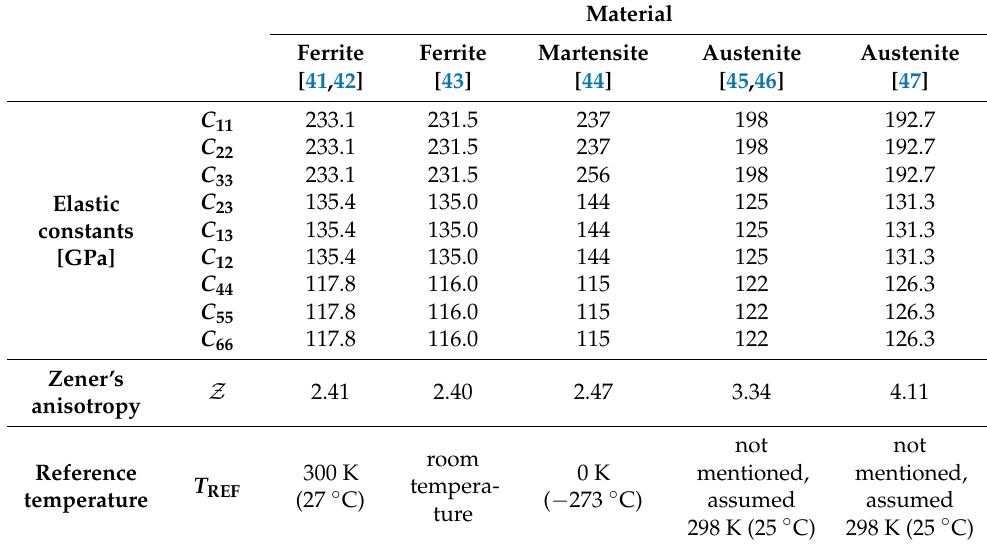
Table 1. Single crystal properties found in